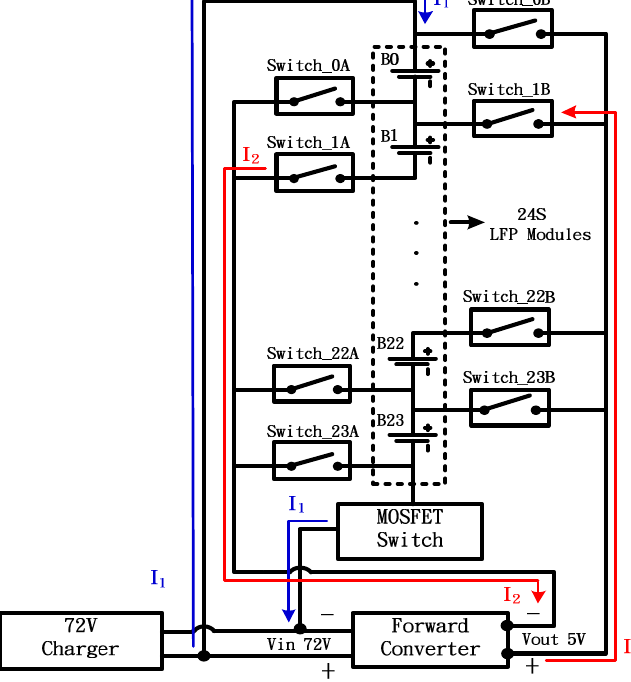
Figure 1. Globally active balance circuit.